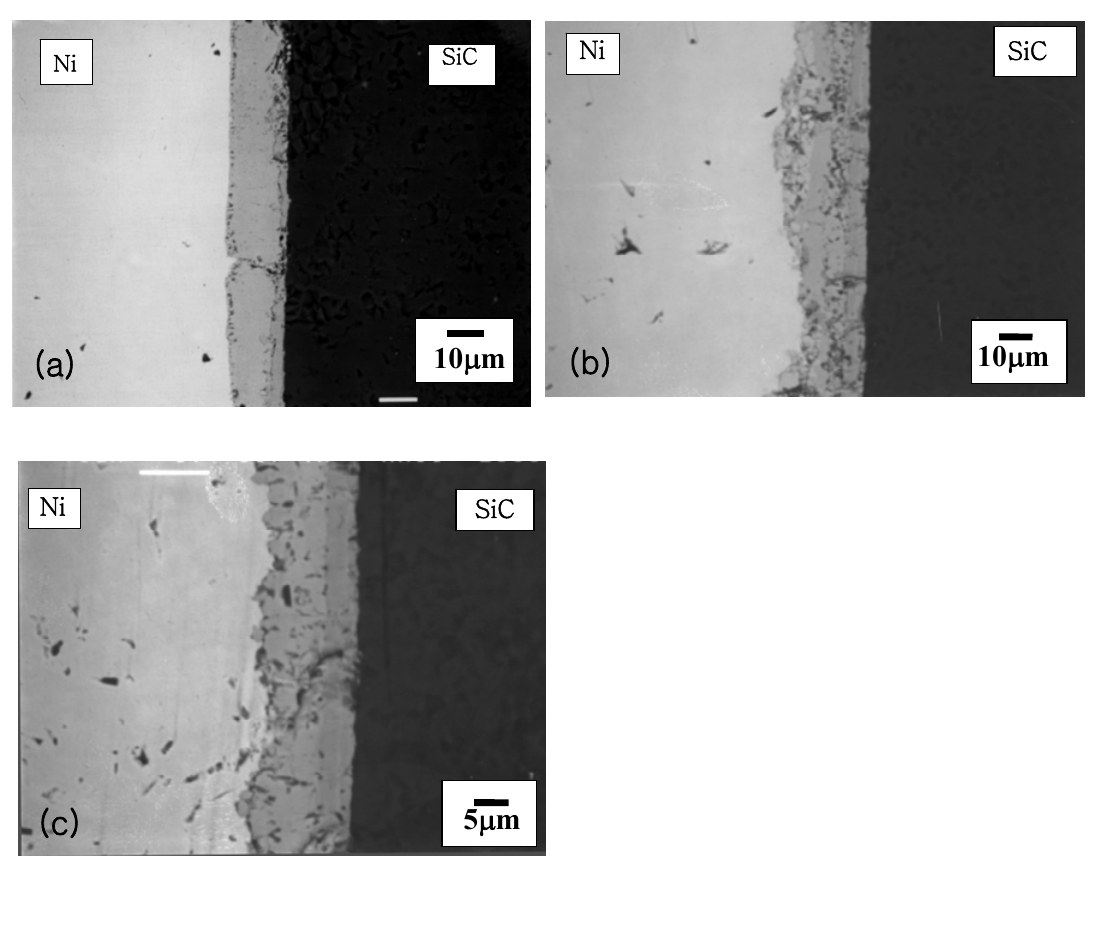
Figure 9. BSE image of Ni/Cr/SiC reaction couple annealed at 900 ° C for (a) 40 h, (b) 80 h and (c)120 h